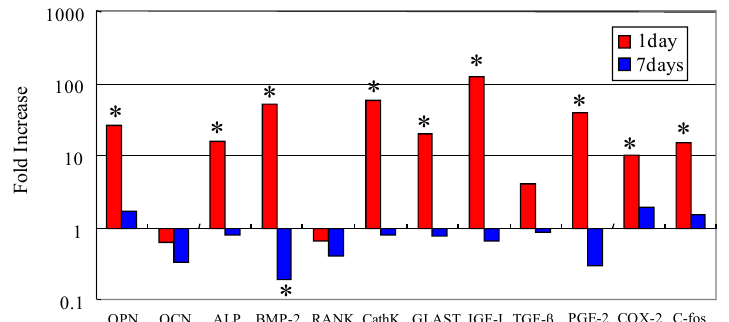
Fig. 8 Gene expression of load group, compared to control after 1 and 7